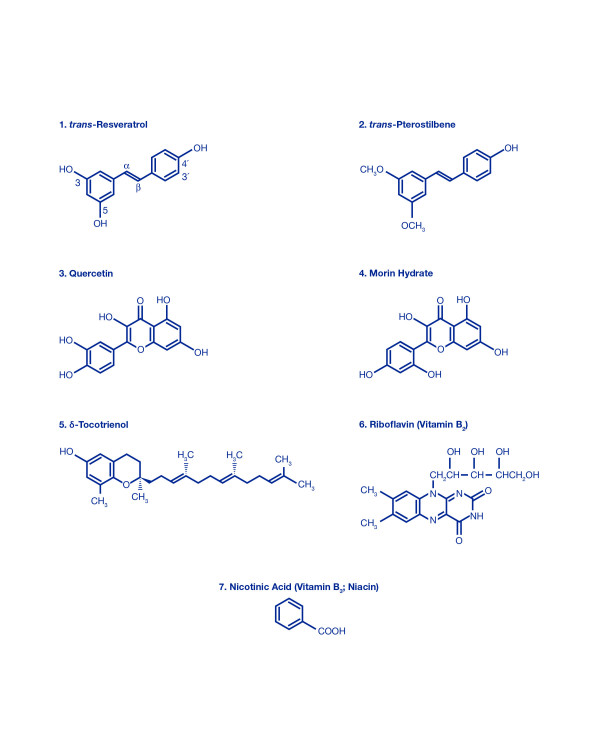
Chemical structures of various compounds used in this study.